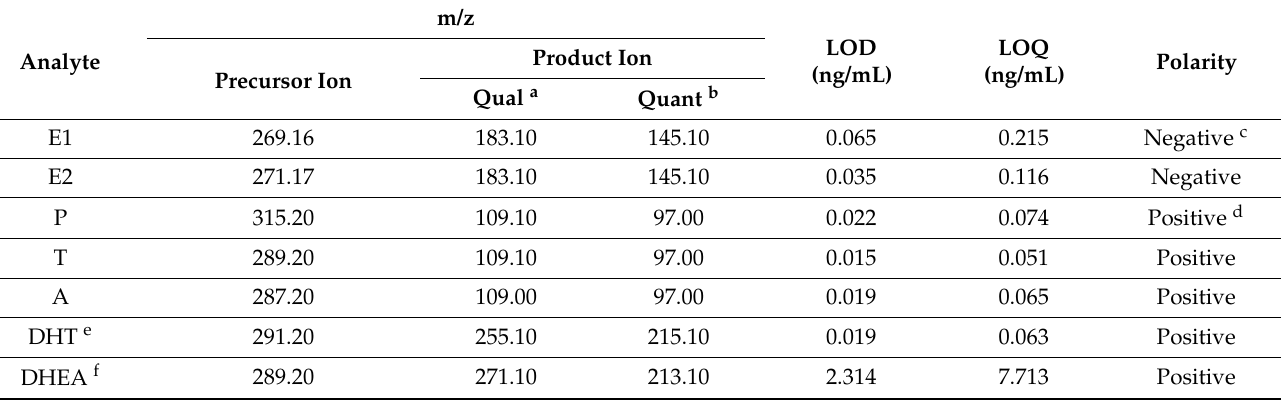
Table 1. Hormone compounds monitoring conditions for LC/QQQ analyses. Here, we illustrated precursor/product ion combinations, LOD/LOQ, and